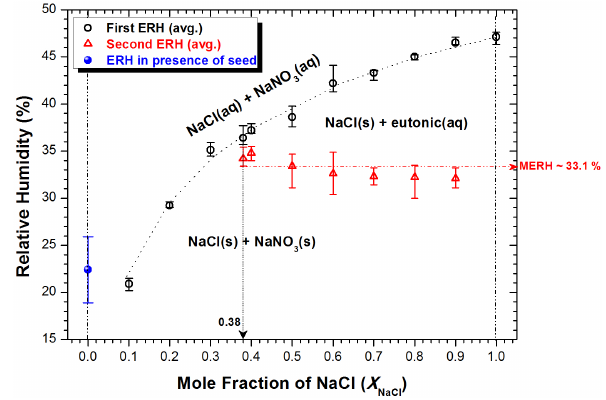
Figure 4. Measured first-ERH values (open circles) and second- ERH values (open triangles) as a function of the mole fraction of NaCl in NaCl–NaNO 3 mixture particles as well as ERH (closed cir- cle) for wet deposited NaNO 3 particles containing seeds. The phase notations shown in brackets are s = solid; and aq =